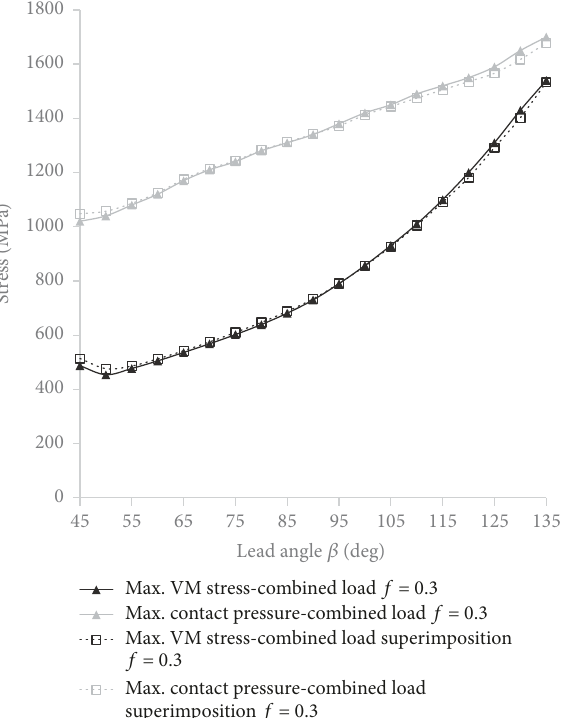
Figure 14: Maximum equivalent stress and contact pressure for different lead angles under combined load calculated by means of the FEM model (friction factor = 0.3) as well as by summing results from analyses under force and torque